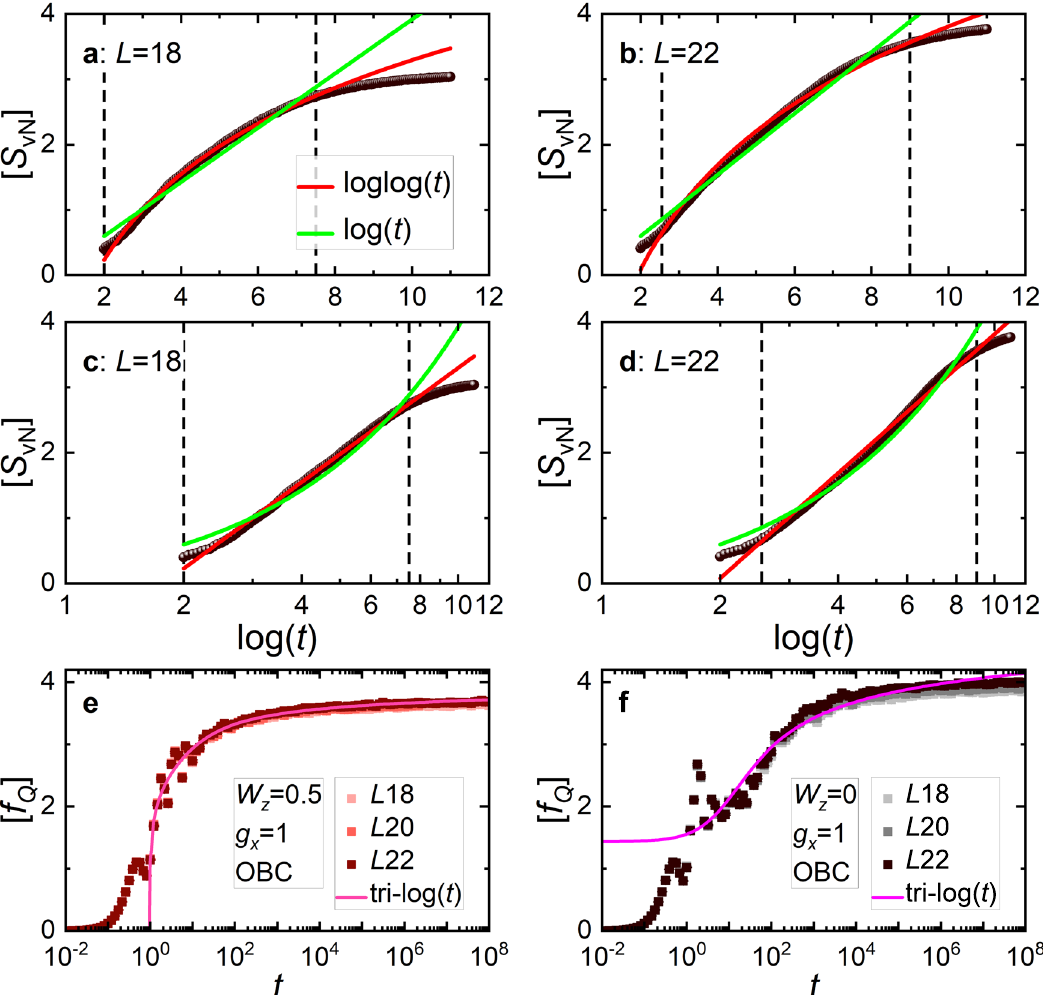
Fig. 6 Re fi ned data analyses. a , c A replot of [ S vN ] in cMBL (stabilized by g x ¼ 1 ; W z ¼ 0 ) on an open chain of L = 18 but now fi tted by two W x W x different types of functions: loglog ð t Þ and log ð t Þ . The lower panel is the same as the upper one but in a semi-log format. Apparently, loglog ð t Þ gives the better fi t. b , d The [ S vN ] data of a long open chain L = 22 with the same model parameters. In each panel, the time interval that matches the double-log fi t is marked by two dashed lines. Noticeably, this time window broadens from t ∈ (100, 10 7.5 ) for L = 18 to t ∈ (360, 10 9 ) for L = 22. e , f Temporal growth of [ f Q ] at two representative points inside the cMBL dome using longer chains. Both can be captured by the triple-log functions of time. e corresponds to W z = 0.5, while f repeats Fig. 5d for